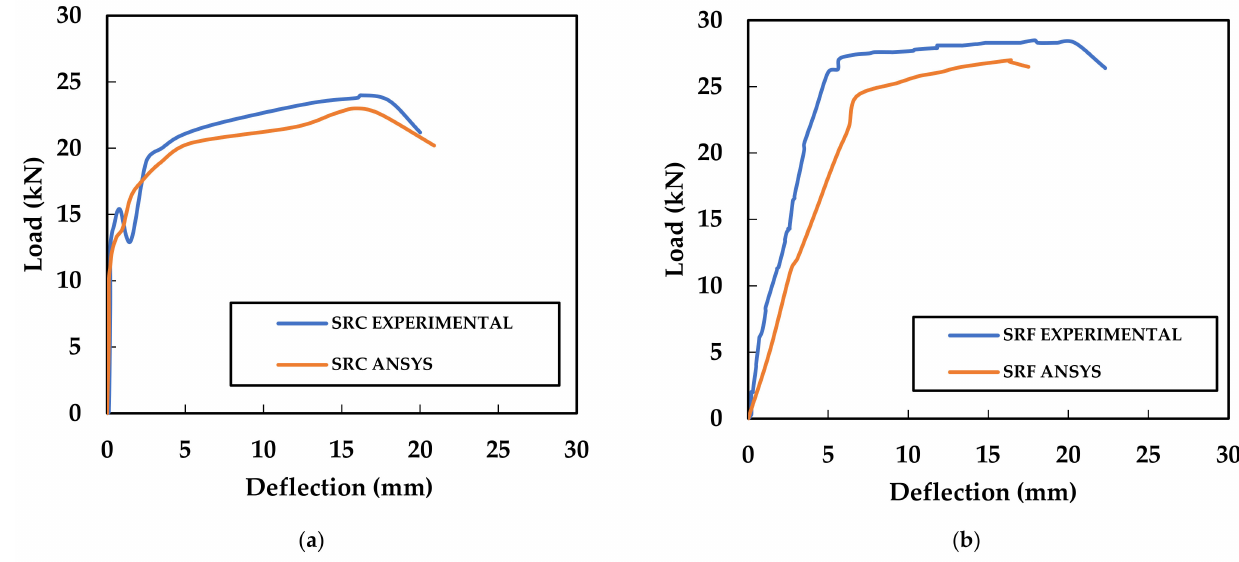
Figure 22. Comparison between experimental and numerical load–deflection relationship of ( a ) SRC and ( b ) SRF.